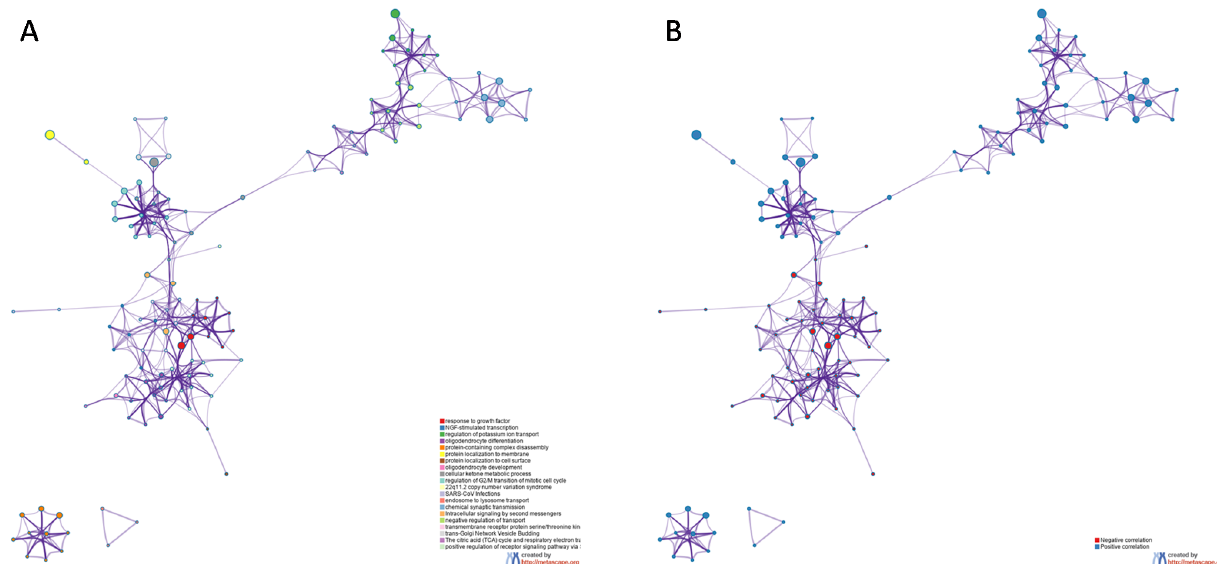
Figure 5. Enrichment analysis for the genes most correlating with LSGALS8 in SCZ hippocampus. Genes significantly correlated to LSGALS8 in SCZ hippocampus were identified by calculating the Pearson correlation, and the statistical significance was computed using a permutation test, with 1000 random permutations. ( A ) Network showing the interconnection among the most enriched terms. Each term is represented by a circle node, with a size proportional to the number of genes that fall into each term, and the color representing the cluster identity; ( B ) the same network with the nodes colored based on whether the specific enriched term is enriched by either the genes positively (blue) or negatively (red) correlated to LGALS8 .